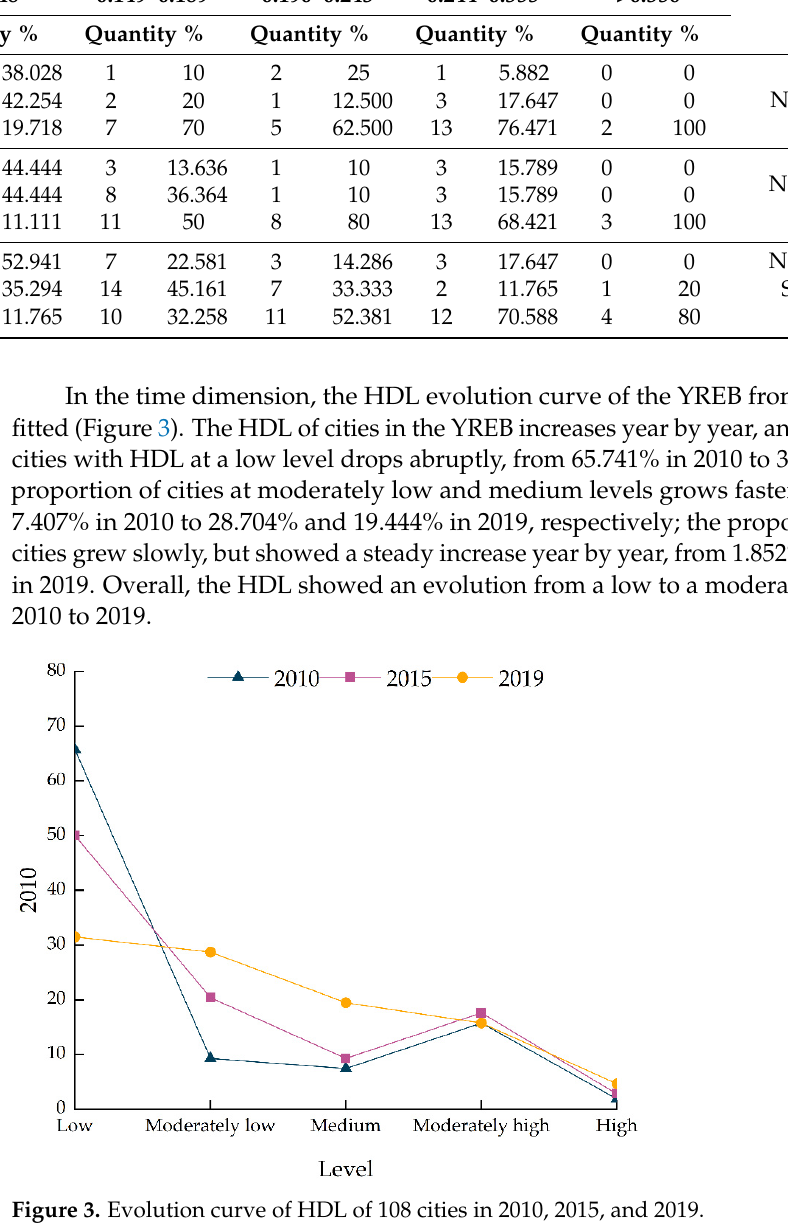
Figure 3. Evolution curve of HDL of 108 cities in 2010, 2015, and 2019.